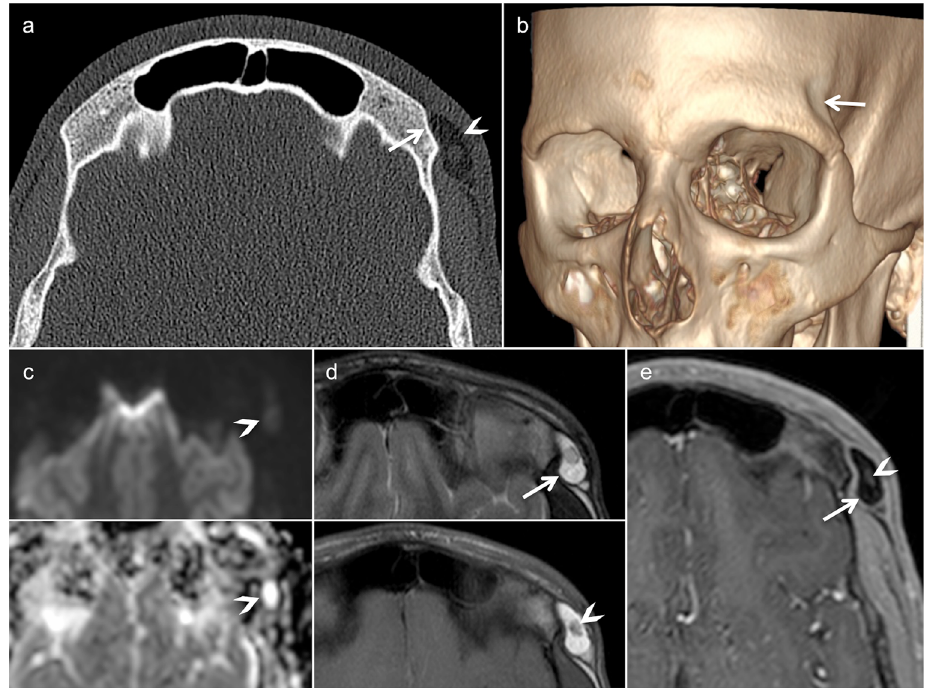
Fig. 8 DC with bone remodelling in a 14-year-old male with lateral supra- orbital soft tissue swelling and induration. a Axial CT (bone window) shows well-demarcated cystic subcutaneous lesion ( arrowhead ) with frontal bone scalloping and no cortical erosion ( arrow ). b Three-dimensional CT VR reconstruction shows bone remodelling in the supraorbital left area ( arrow ). c DWI reveals high signal on the b=1000 image ( arrowhead , upper image part ) and high signal on the ADC map ( arrowhead , lower image part ,